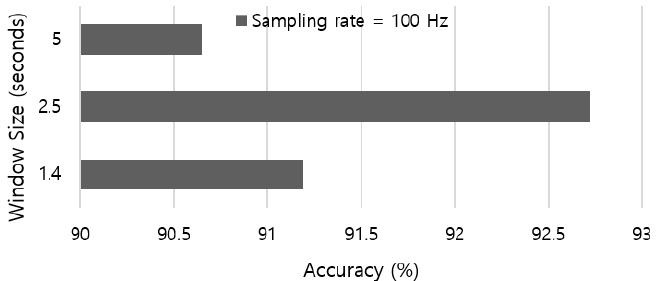
Figure 3. Recognition accuracy according to various length of sliding window.